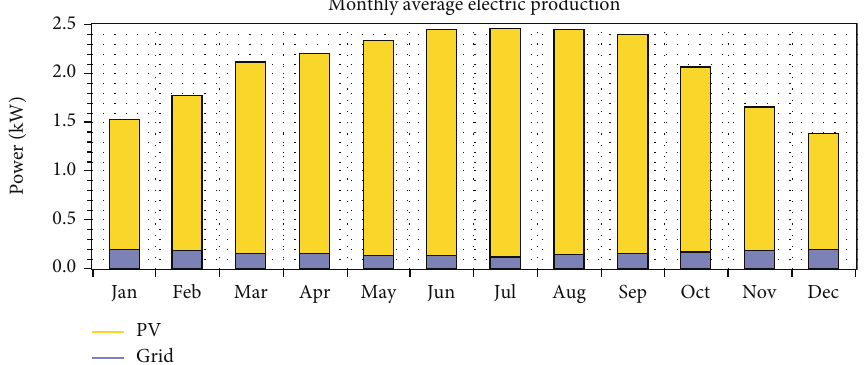
Figure 8: Monthly average electricity